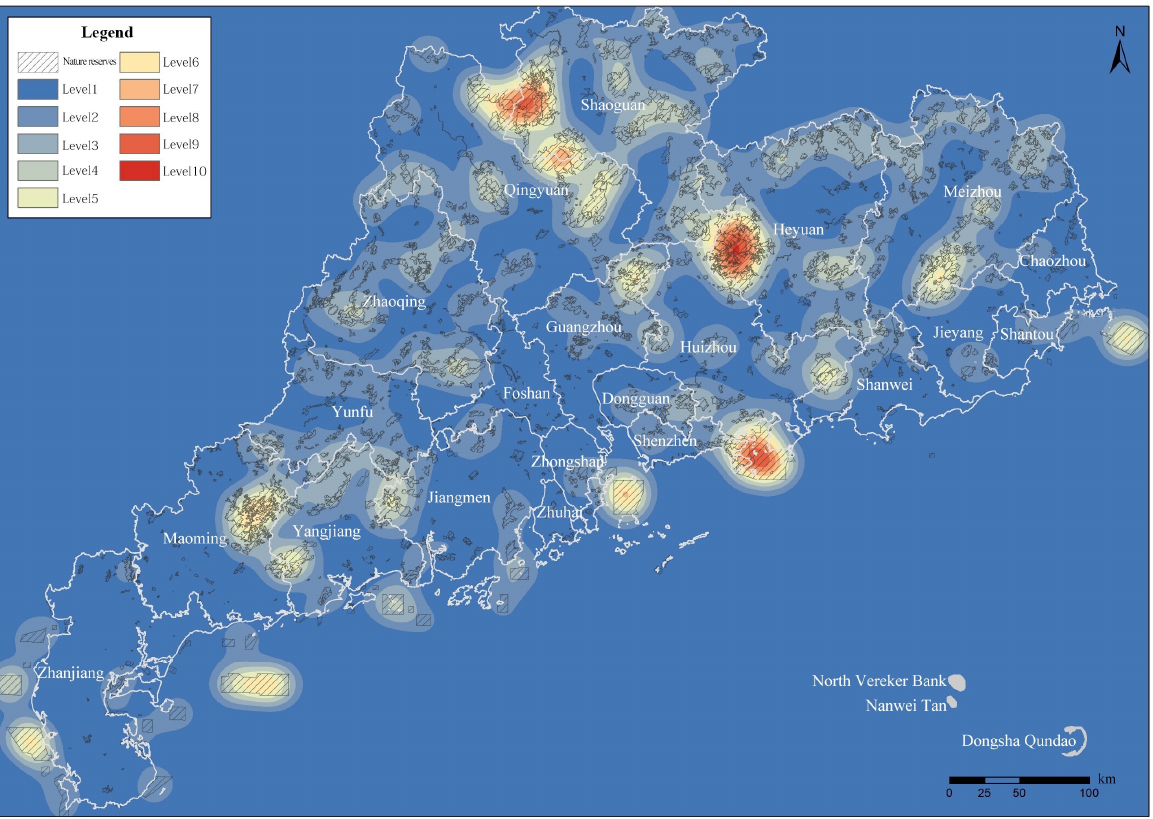
Figure 9. NPAs’ kernel density classification map.